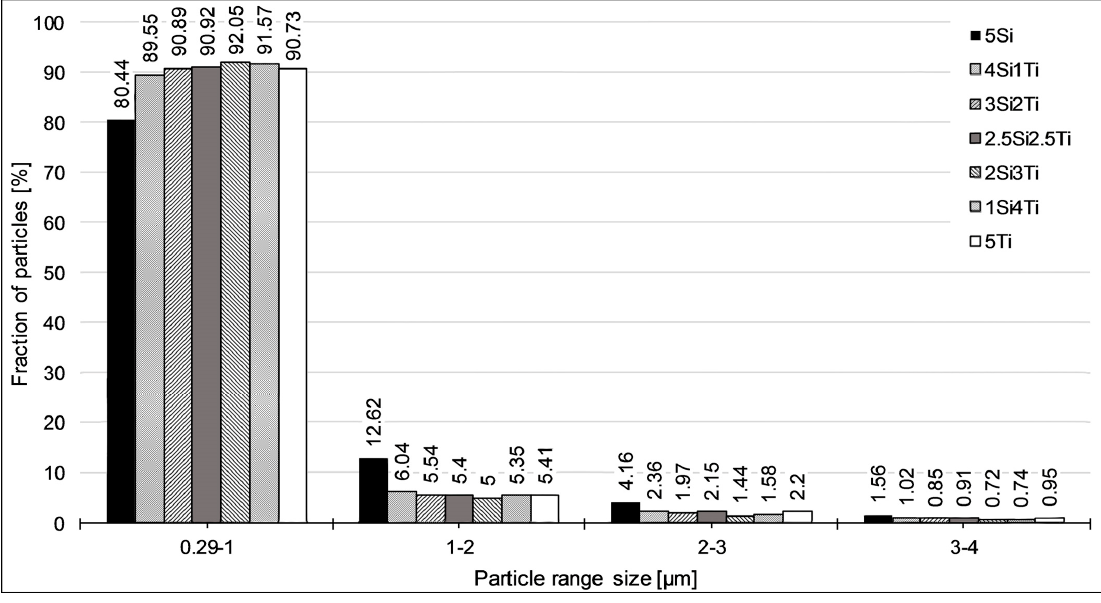
Figure 1. Zetasizer results.